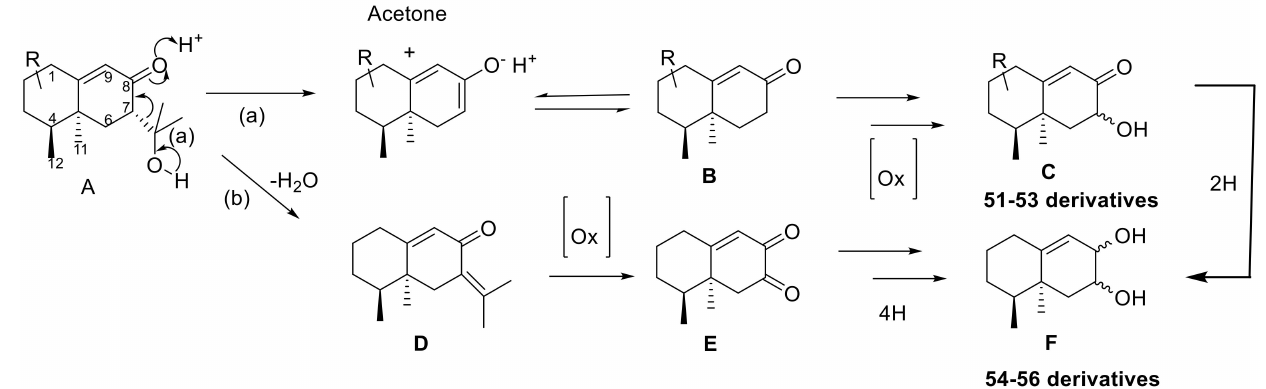
Figure 15. Biosynthetic pathway proposed for 11,12,13-tri- nor -eremophilenes.